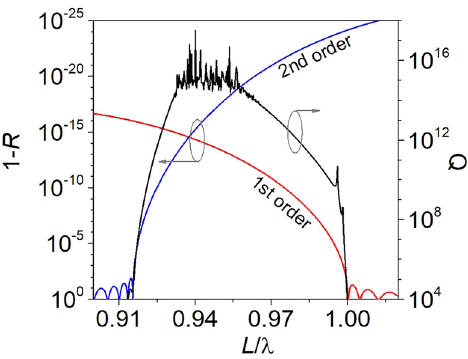
Figure2: Q -factor(blackline)ofthemodeindicatedby(1)inFigure2 and power re fl ectance of the DBR for the fi rst (red line) and second (blue line) diffraction orders as a function of L / λ .